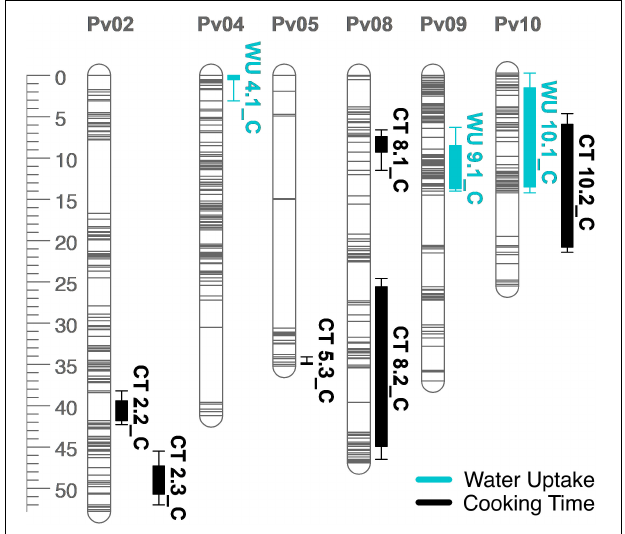
FIGURE 6 | QTL map for water uptake (WU) and cooking time (CT) in the RIL population. Size is in cM. All QTL were detected in both years